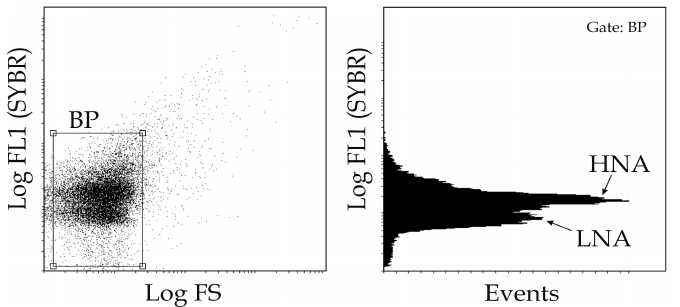
Figure 3. Gating total bacterioplankton (BP), HNA-, and LNA-bacteria in the space of direct light scattering (FS, cell size), and green fluorescence (FL1, SYBR).